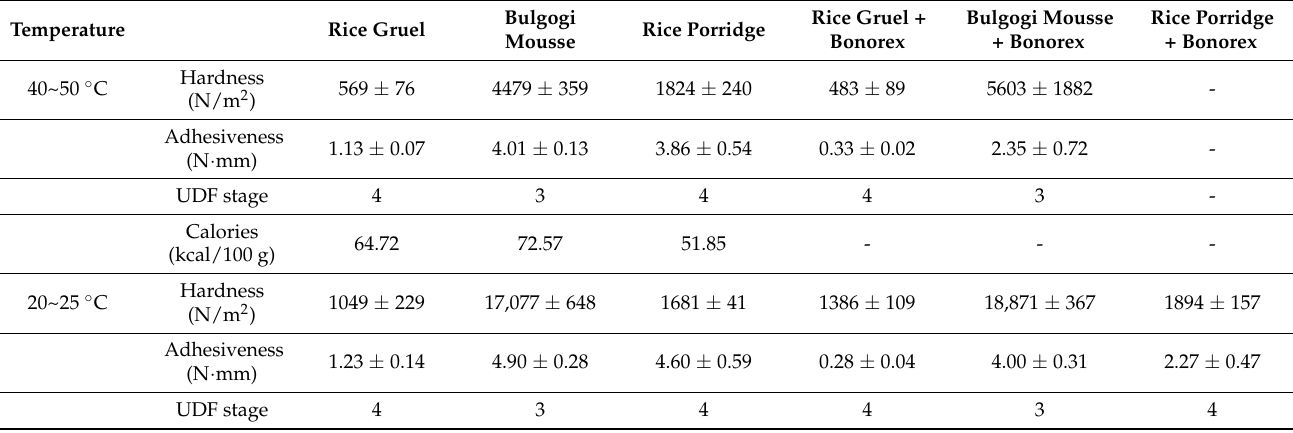
Table 3. Results of text analysis of the study and control